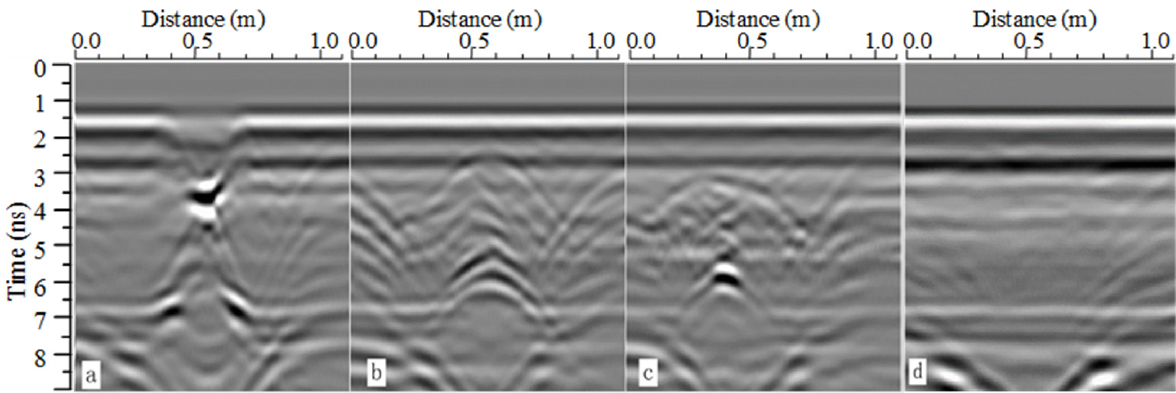
Figure 11. GPR raw radargrams before and after irrigation: ( a ) For a drip irrigation SWB; ( b ) for a subsurface bubble irrigation SWB; ( c ) for a moistube irrigation SWB; ( d ) before irrigation (no SWB).